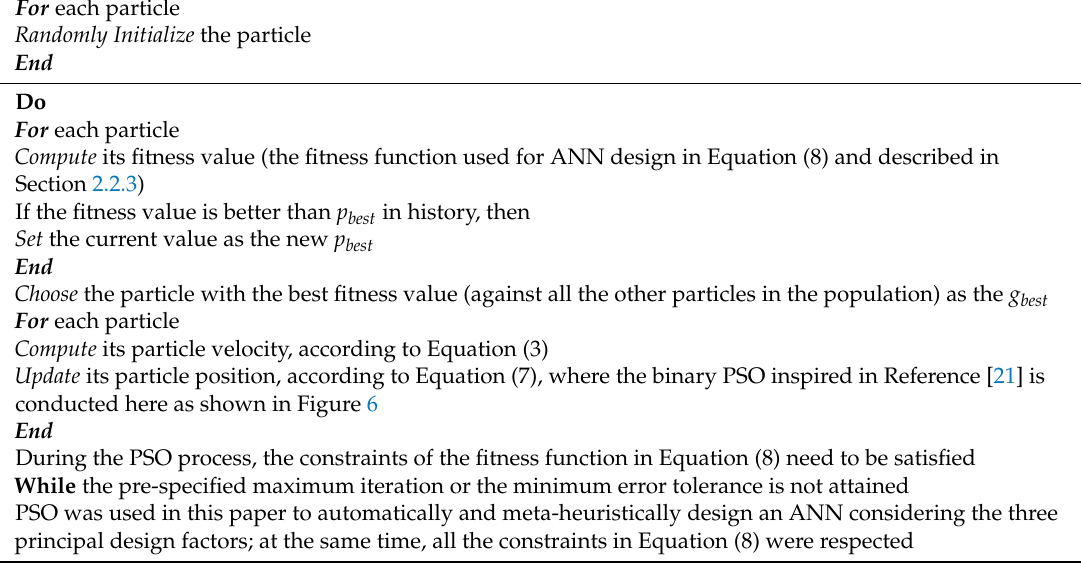
Table 1. The PSO with its variants proposed in Reference [22] and used in this